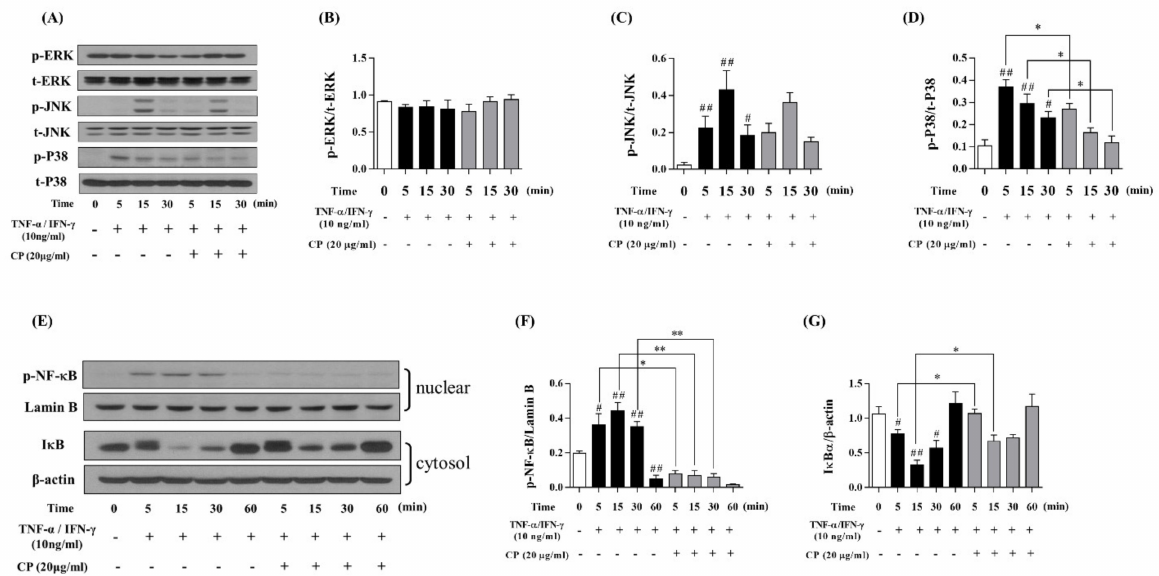
Figure 4. Effect of CP on MAPK signaling pathway in TNF- α /IFN- γ -stimulated HaCaT cells. ( A – D ) HaCaT cells were treated with CP (20 µ g/mL) for 1 h and then stimulated with TNF- α /IFN- γ for 5, 15 and 30 min. The phosphorylation of MAPKs was analyzed by western blot analysis. Phosphorylations of MAPKs (ERK, JNK, P38) were normalized to total MAPKs. ( E – G ) HaCaT cells were treated with CP (20 µ g/mL) for 1 h and then stimulated with TNF- α /IFN- γ for 5, 15, 30 and 60 min. The phosphorylation of the NF- κ B/I κ B α signaling pathway was analyzed using western blot analysis. p-NF- κ B was normalized to Lamin B, and I κ B α was normalized to β -actin. All data represent the means ± SEM ( # p < 0.05 and ## p < 0.01 vs. TNF- α /IFN- γ non-treat group. * p < 0.05 and ** p < 0.01 vs. only TNF- α /IFN- γ -treat